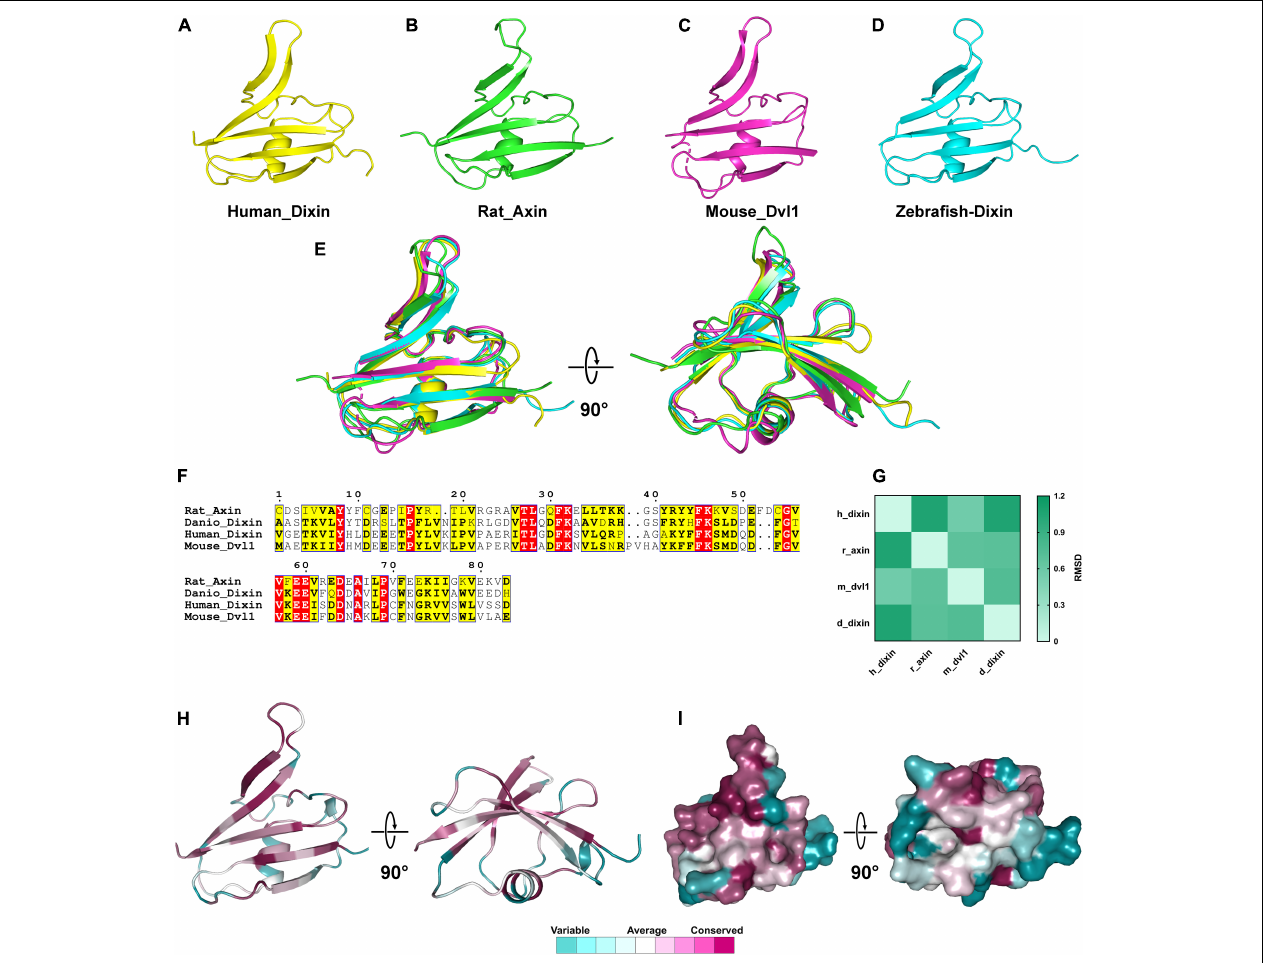
FIGURE 9 | The 3D structures of DIX domains from different species are evolutionarily conserved. (A–D) 3D structures of Wnt domains from human, rat, mouse and zebrafish. (E) Structural alignments of Wnt domains from different species and the colors correspond to panels (A,B,C,D) . (F) Amino acids sequences alignment of DIX domains. (G) RMSD matrix of alignments of DIX domains from different species. (H,I) Residue and surface conservation of the mouse DIX